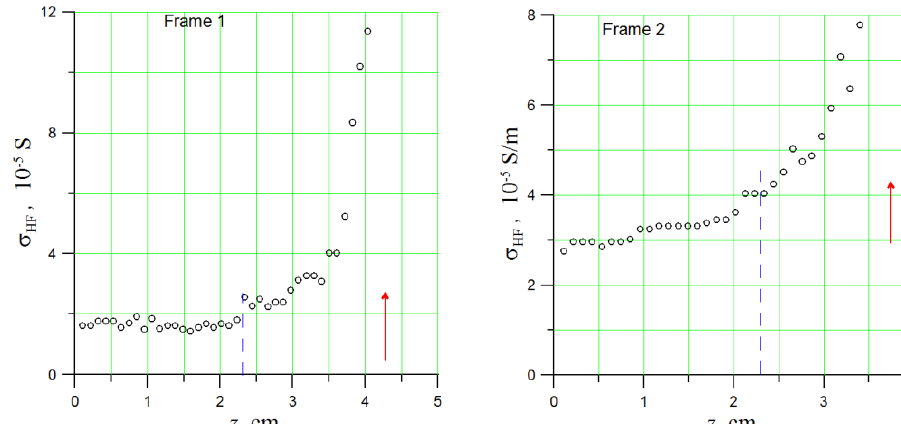
Fig. 5. High-frequency conductivity on the axis of the streamer zone for two frames presented in Fig.